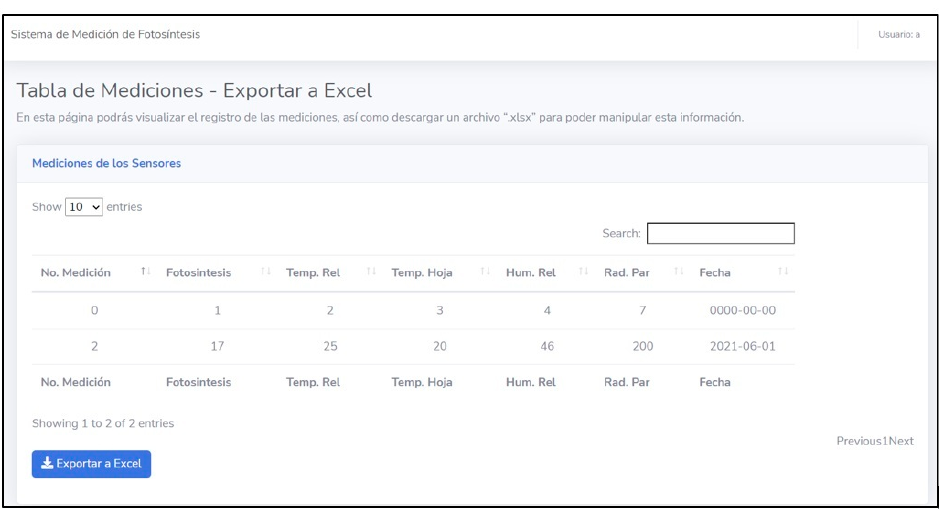
Figure 15. Table of measurements obtained during the test session displayed on the main page.